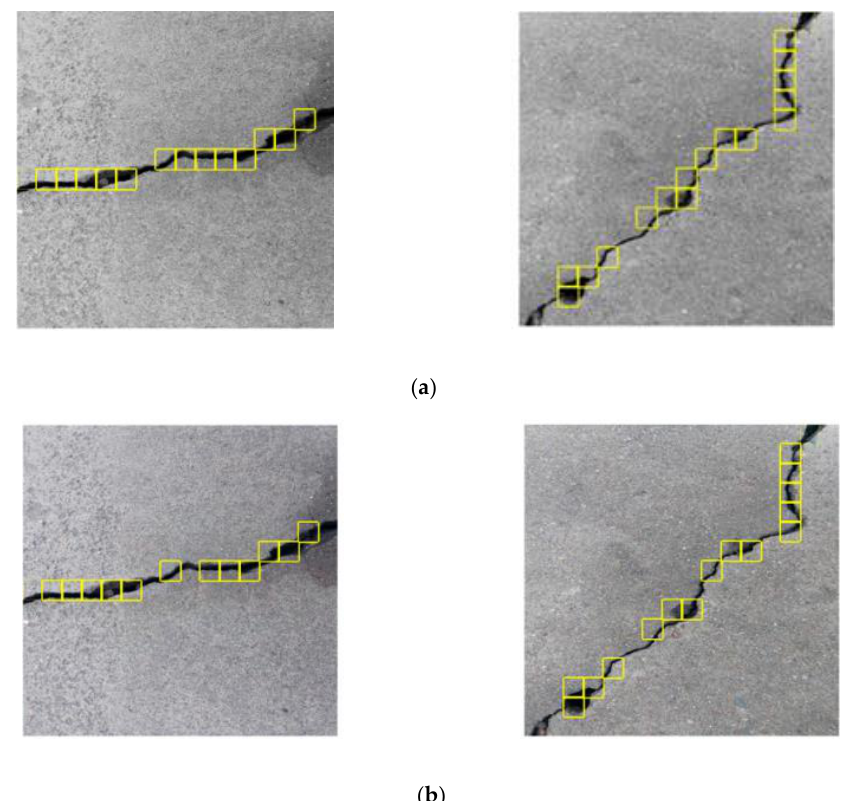
Figure 9. Crack position detection (CPD) results using the ( a ) constructed CPD and ( b ) Alexnet